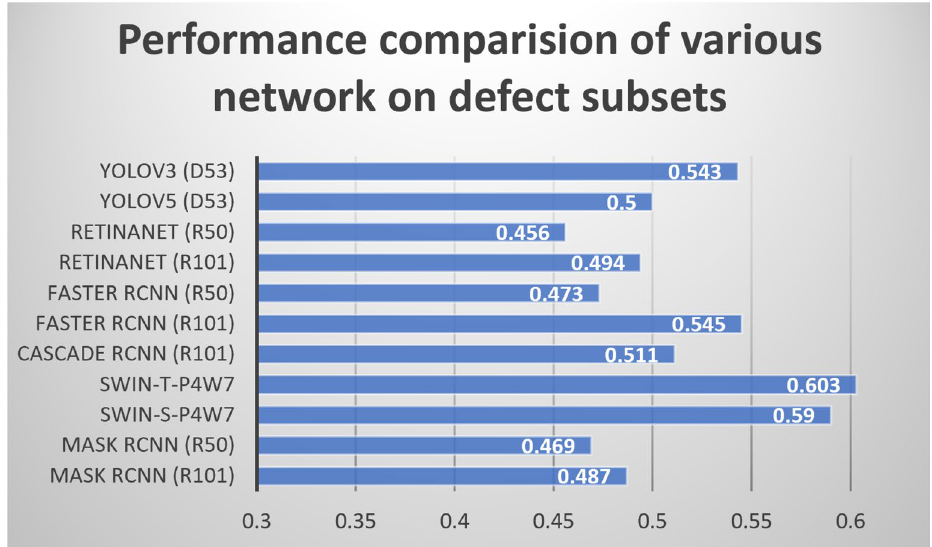
Figure 9. Performance comparison of various networks on the local defect database in terms of mAP. D53, R50, and R101 represent DarkNet53, ResNet50, and ResNet 101 backbones, respectively. SWIN-T-P4W7 and SWIN-S-P4W7 indicate very small Swin transformer models, respectively.